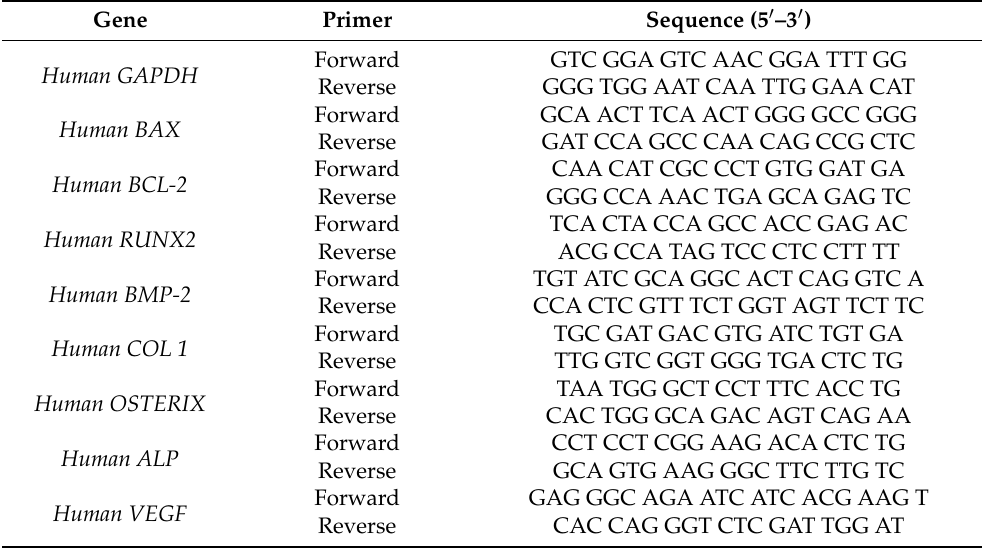
Table 1. Quantitative real time polymerase chain reaction (qRT-PCR) primer sequences. Gene Primer Sequence (5 (cid:48) –3 (cid:48)